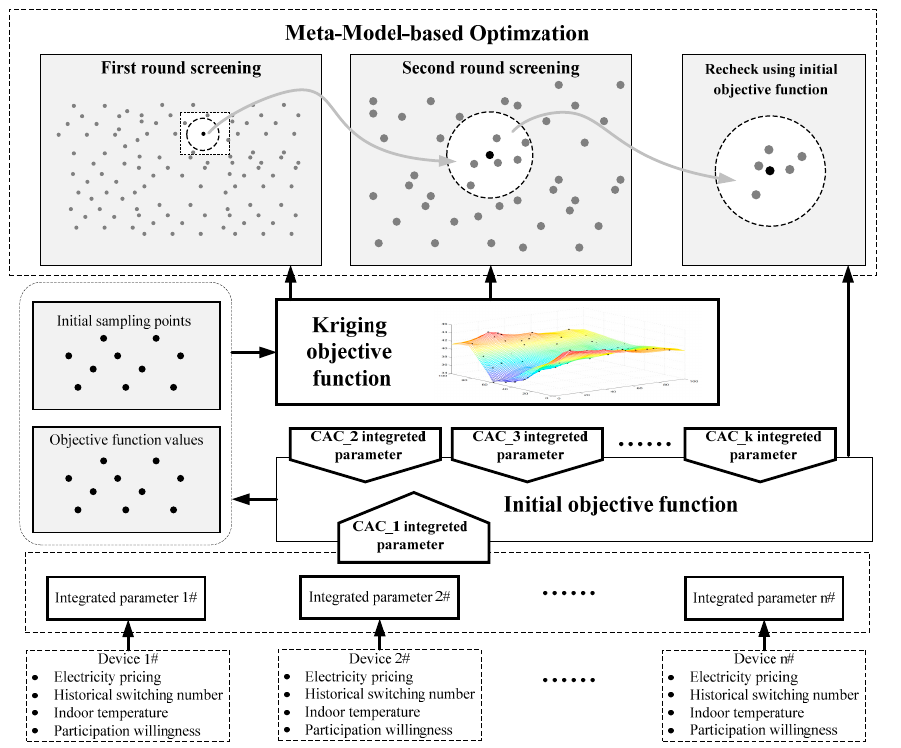
Figure 10. Model solving framework.